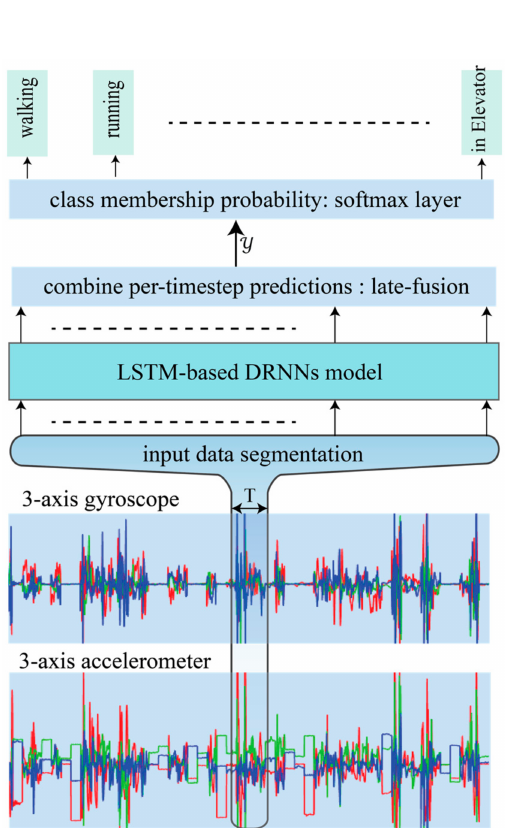
Figure 3. The proposed HAR architecture. The inputs are raw signals obtained from multimodal-sensors, segmented into windows of length T and fed into LSTM-based DRNN model. The model outputs class prediction scores for each timestep, which are then merged via late-fusion and fed into the softmax layer to determine class membership